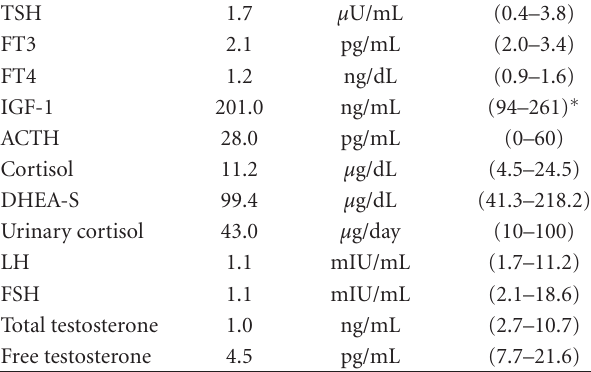
Table 1: Endocrine examinations on admission.